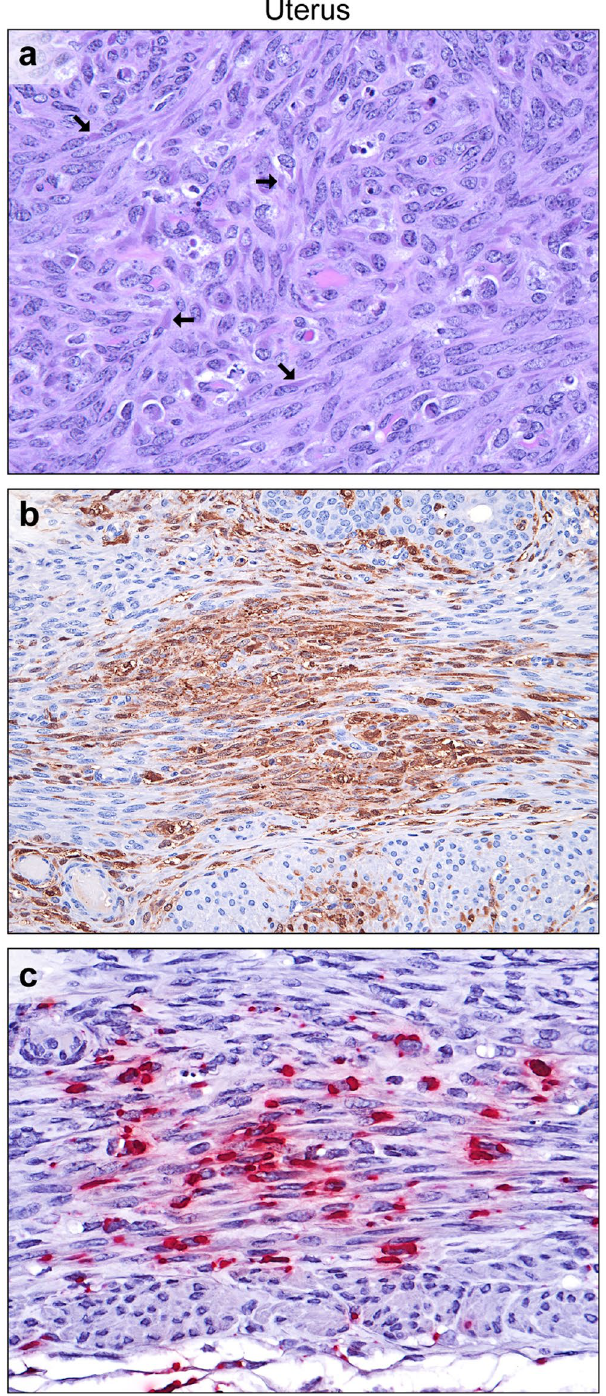
Figure 3. EBOV infection of the uterus. ( a ) Numerous large eosinophilic to amphiphilic intracytoplasmic inclusion bodies (arrows) within smooth myocytes, with scattered apoptosis and necrosis (H&E). ( b ) Smooth myocytes and endometrial stromal cells (EBOV VP40 IHC: DAB chromogen and hematoxylin). ( c ) Myometrial smooth muscle cells (EBOV NP ISH: fast red chromogen and